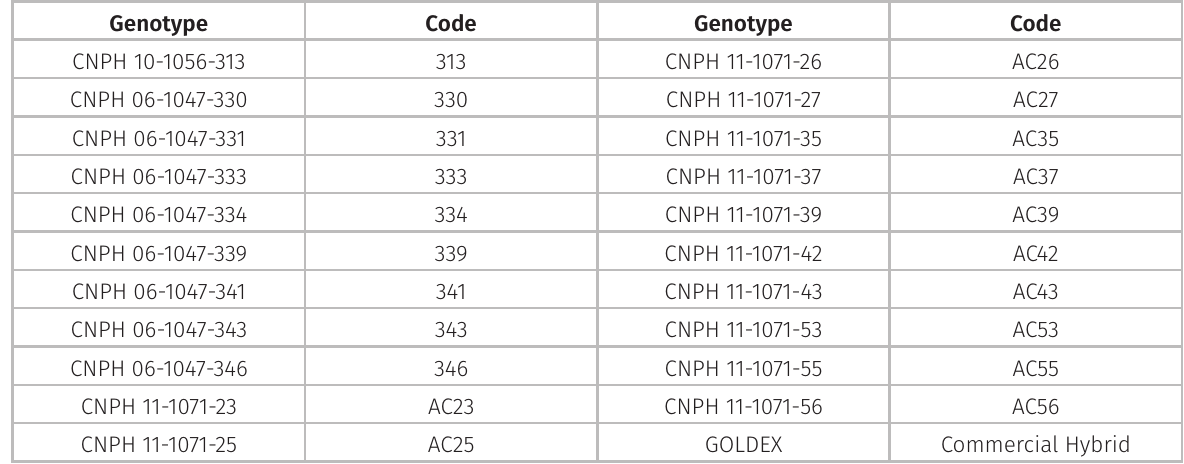
Table I. Selected melon genotypes for the L. sativae resistance test and corresponding codes used in the